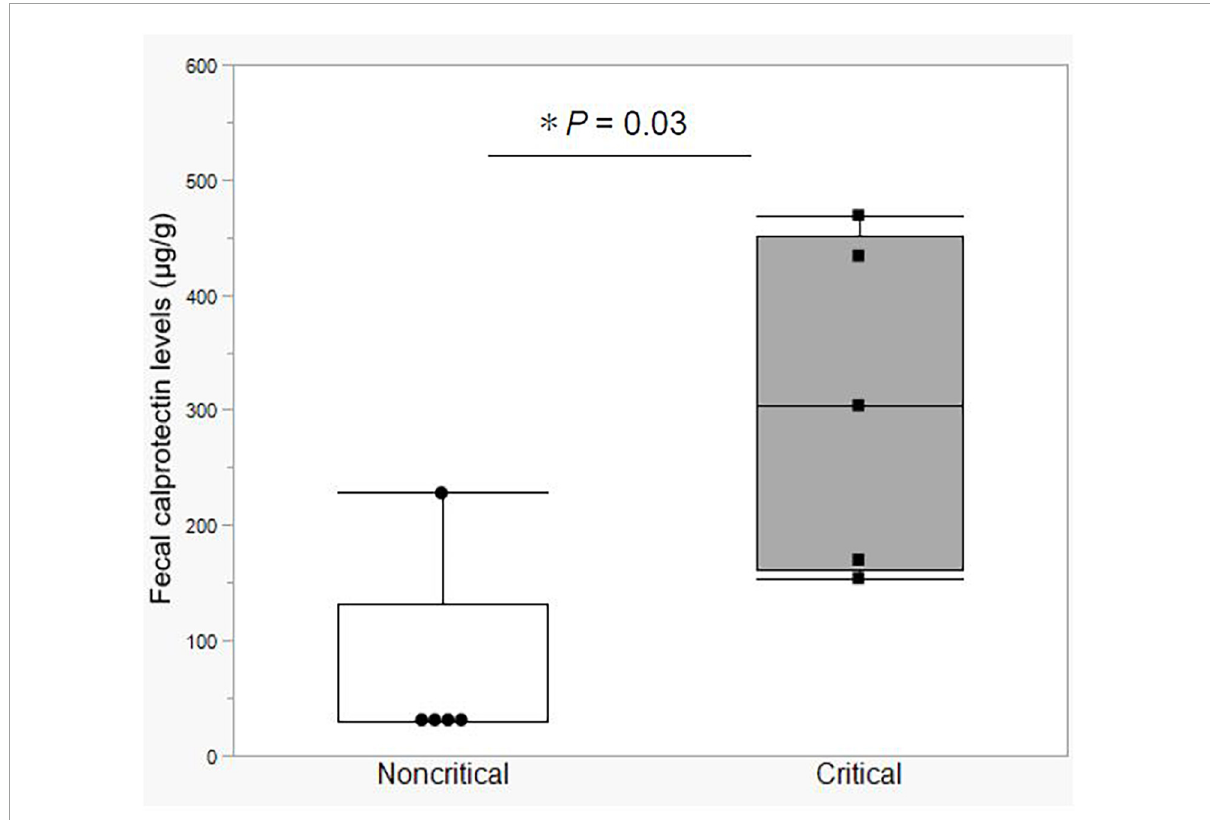
FIGURE1 Fecal calprotectin levels between the non-critical and critical COVID-19 groups. Comparison of fecal calprotectin levels between the non-critical ( n = 5) and critical ( n = 5) COVID-19 groups. Box-and-whisker plots show the median, 25th and 75th percentiles, with whiskers extending to the minimum and maximum values. Each dot indicates individual values. Statistical analysis was performed using Wilcoxon rank-sum test. Statistical significance was accepted as P < 0.05. If the measured FCP value was under 30 µ g/g, which is less than the sensitivity limit of the assay, the result was defined as 30 µ